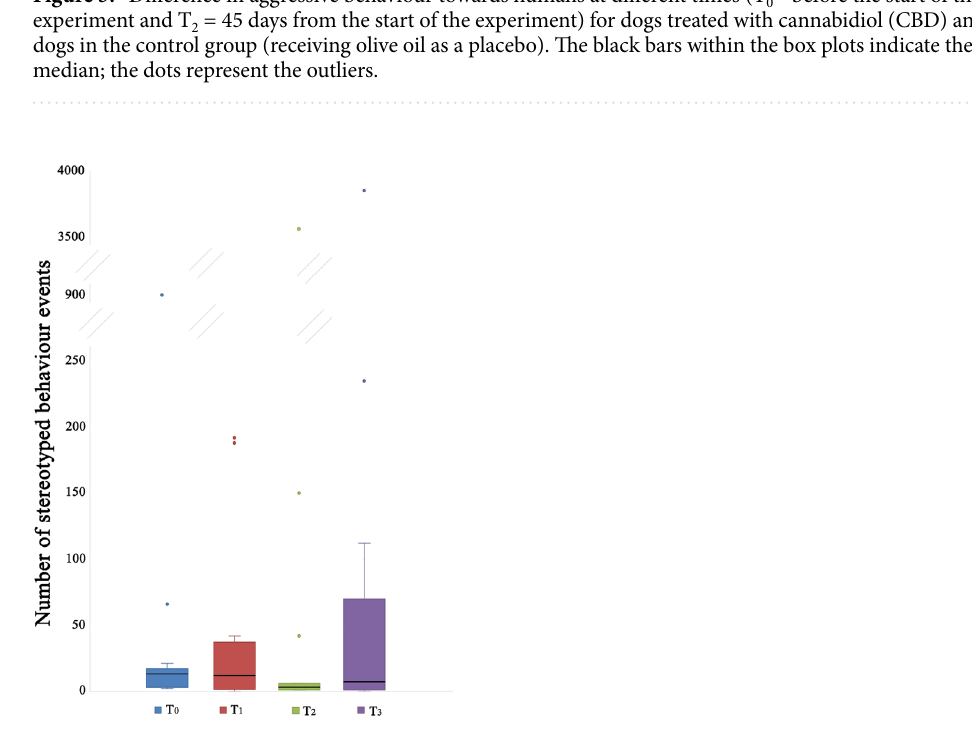
Figure 4. Stereotyped behaviour of dogs treated with cannabidiol (CBD) at the start of the study (T 0 ), after 15 (T 1 ) and 45 (T 2 ) days from the beginning of the treatment, and 15 days after the end of administration of CBD (T 3 ). The black bars within the box plots indicate the median; the dots represent the